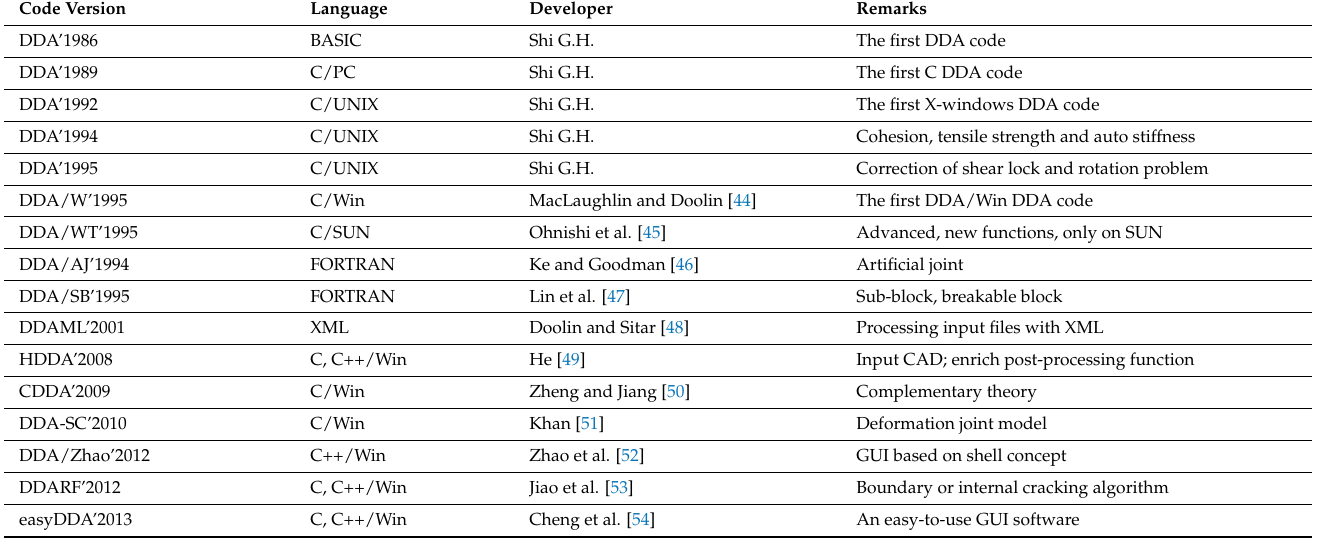
Table 1. Existing open-source program of 2D